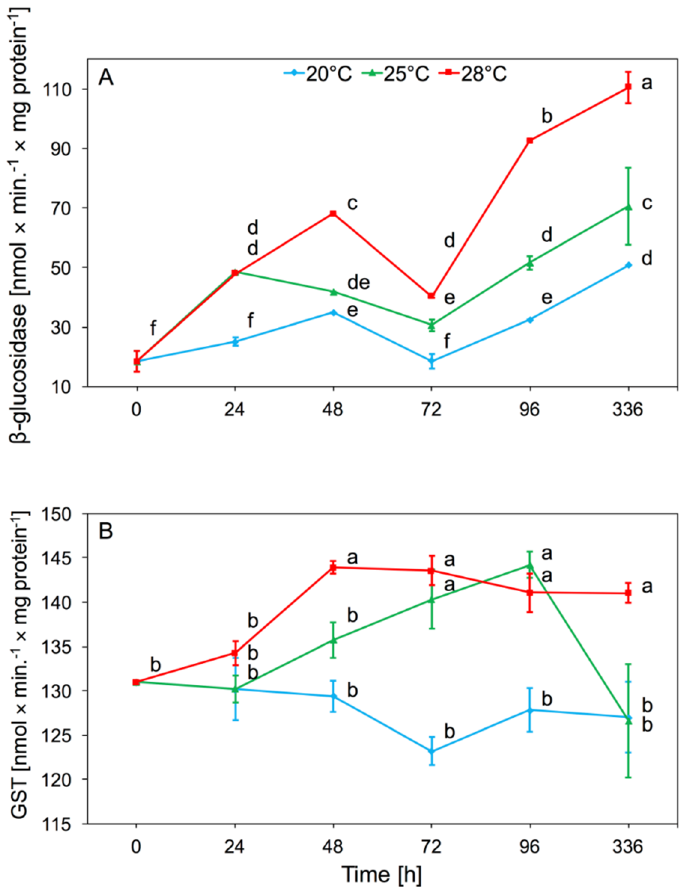
Figure 2. Activity change of β‐ glucosidase ( A ) and s ‐ glutathione transferase (GST) ( B ) in the tissues of A. pomi at temperature 20, 25, and 28 °C (mean ± SE; control = aphids at 20 °C). Values not followed by the same letter are significantly different at the level of p < 0.05 (Duncan multiple range test).